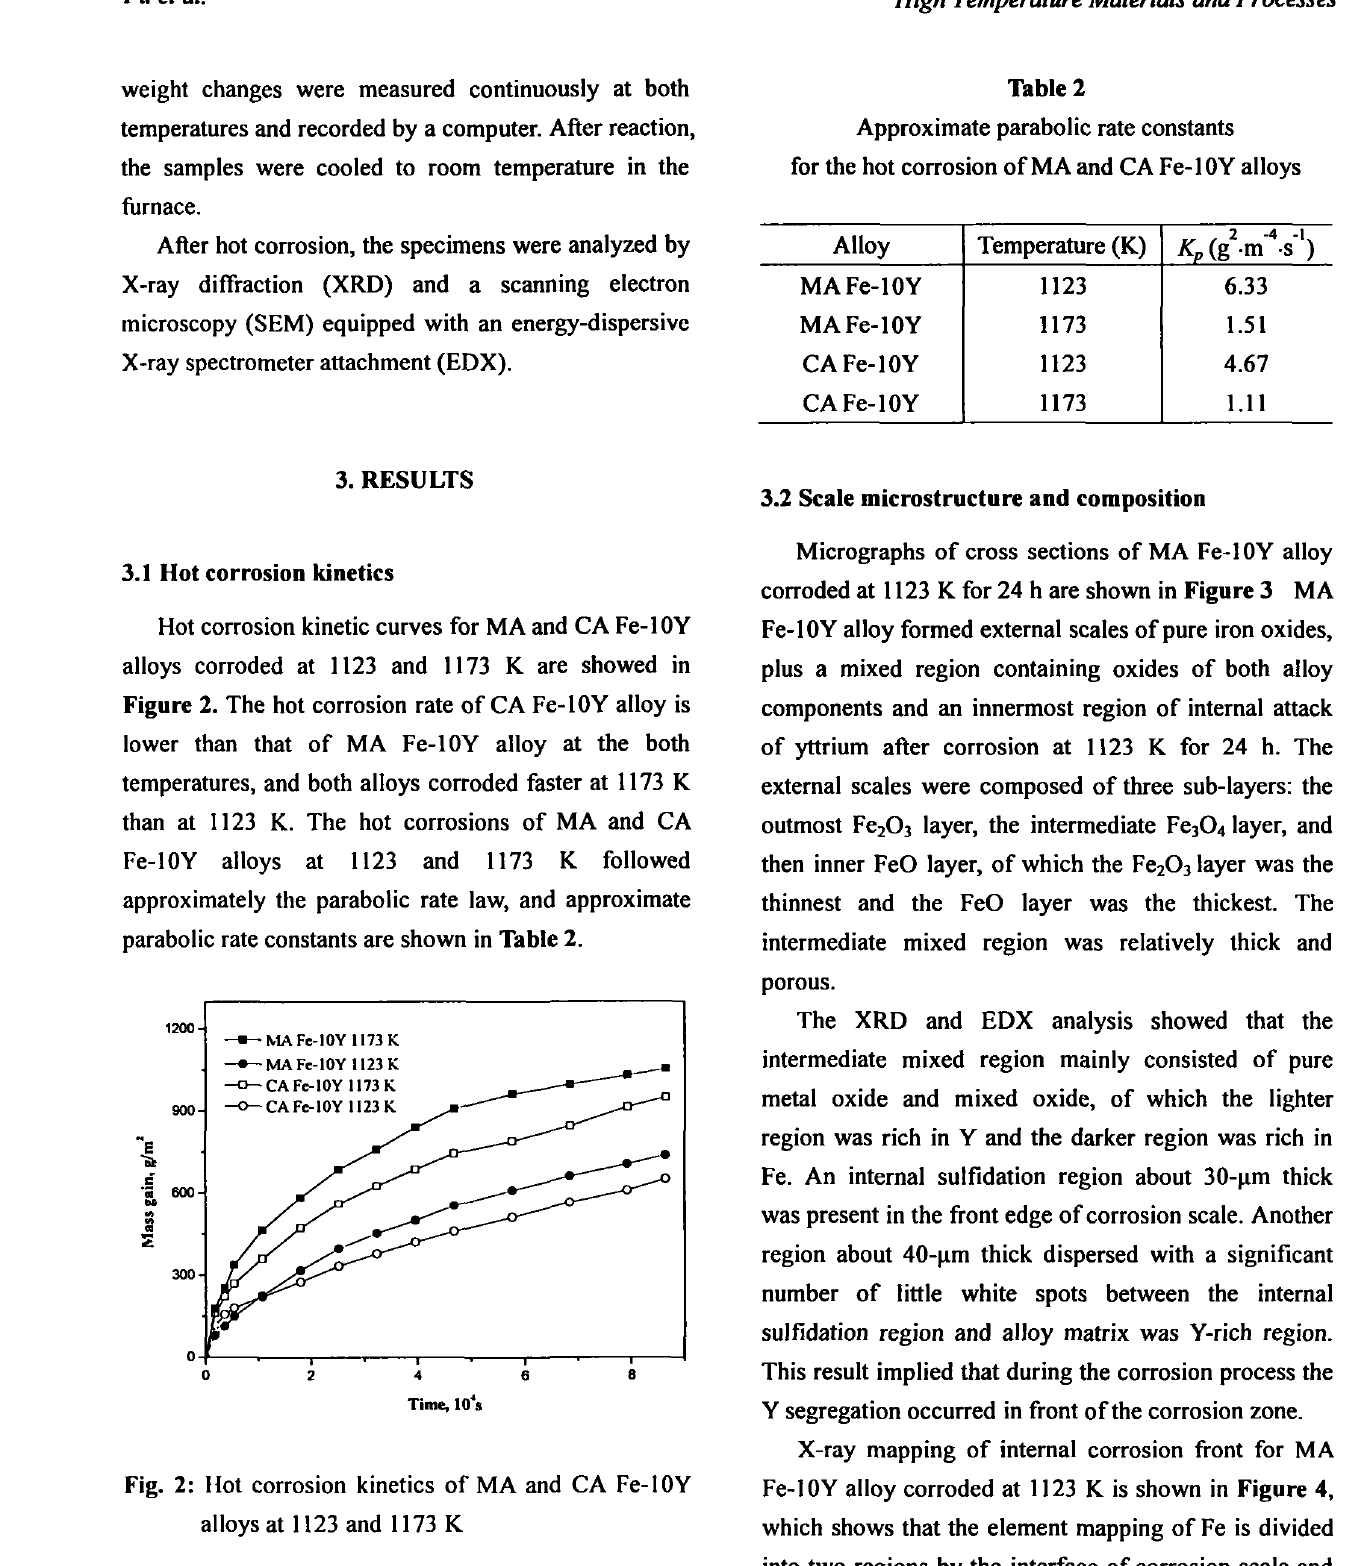
Fig. 2: Hot corrosion kinetics of MA and CA Fe-10Y alloys at 1123 and 1173